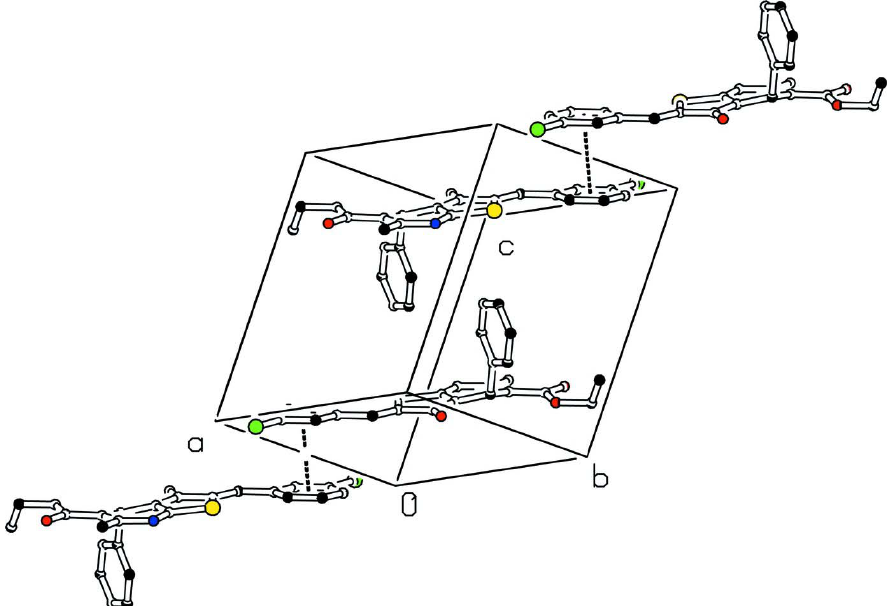
Figure 3 A view of the π – π stacking interaction (dashed line) in the crystal structure of I . H atoms have been omitted for